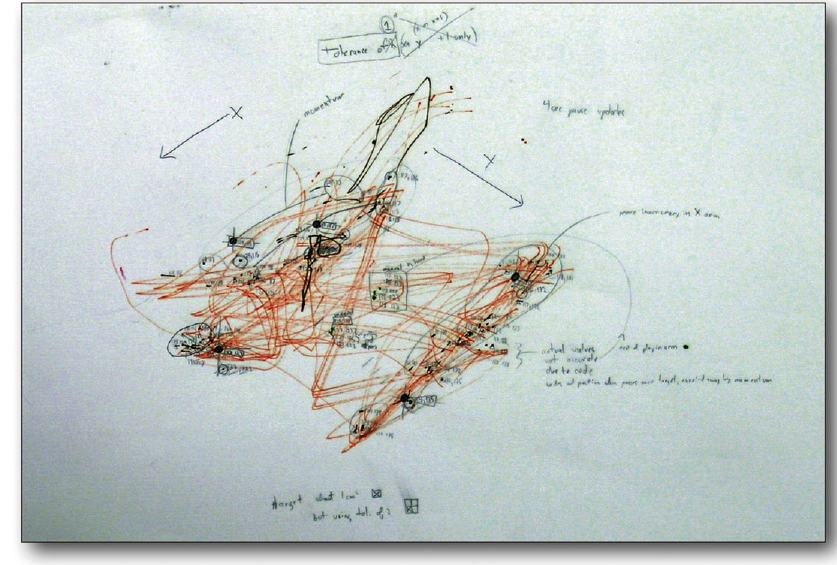
Figure 10. Does MEART create valuable art? MEART drawing and notes from an early accuracy test. This and four other drawings were purchased by a museum in Spain (MEIAC, Museu Ibero Americano de Arte Contemporˆanea) for their permanent